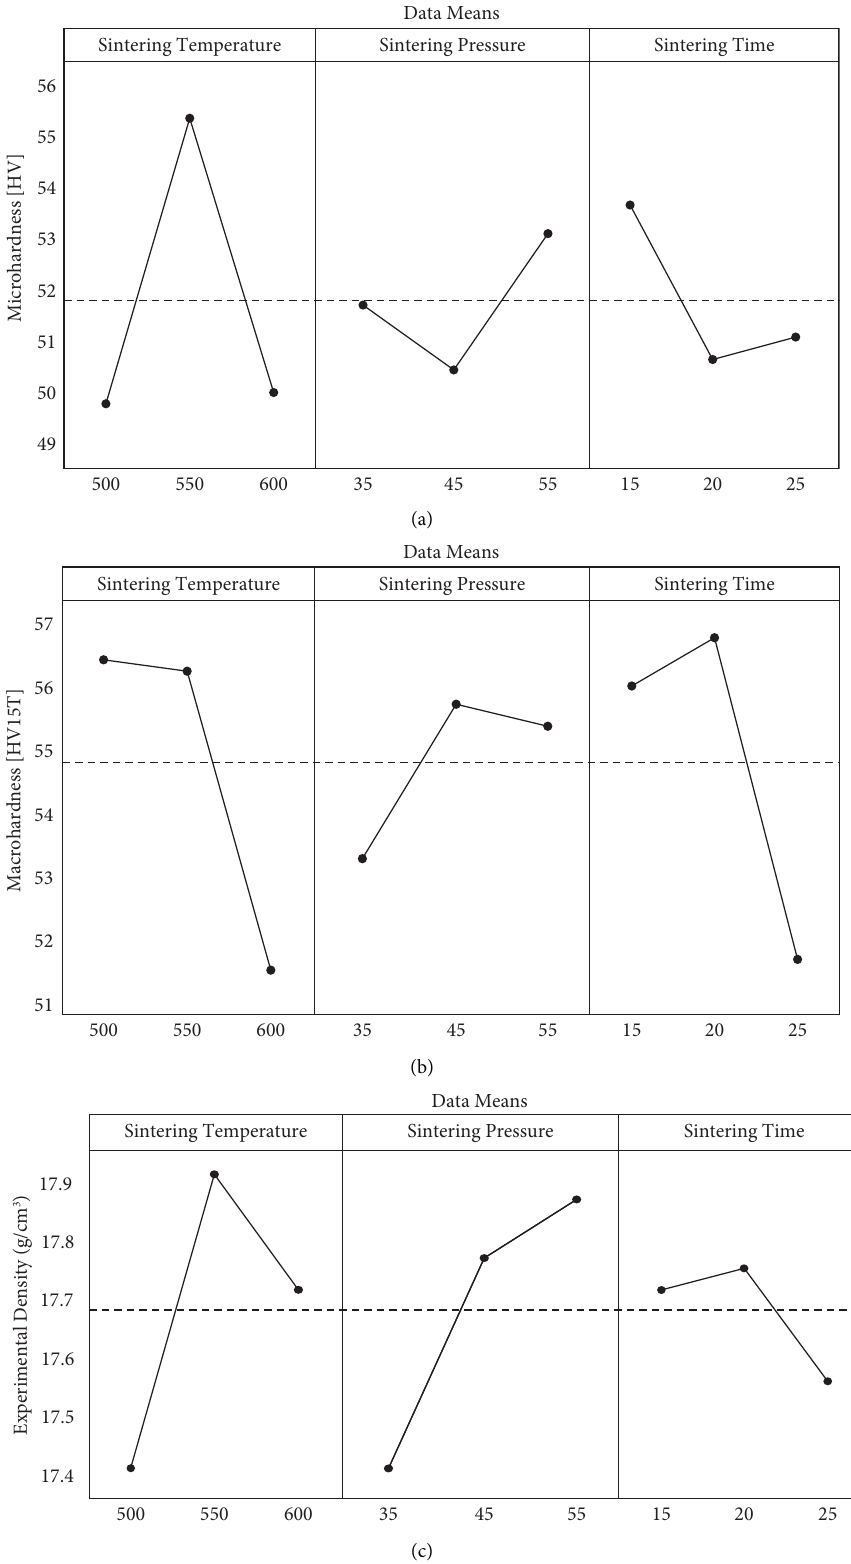
Figure 4: Impact of processing factors on (a) microhardness, (b) macrohardness, and (c) experimental